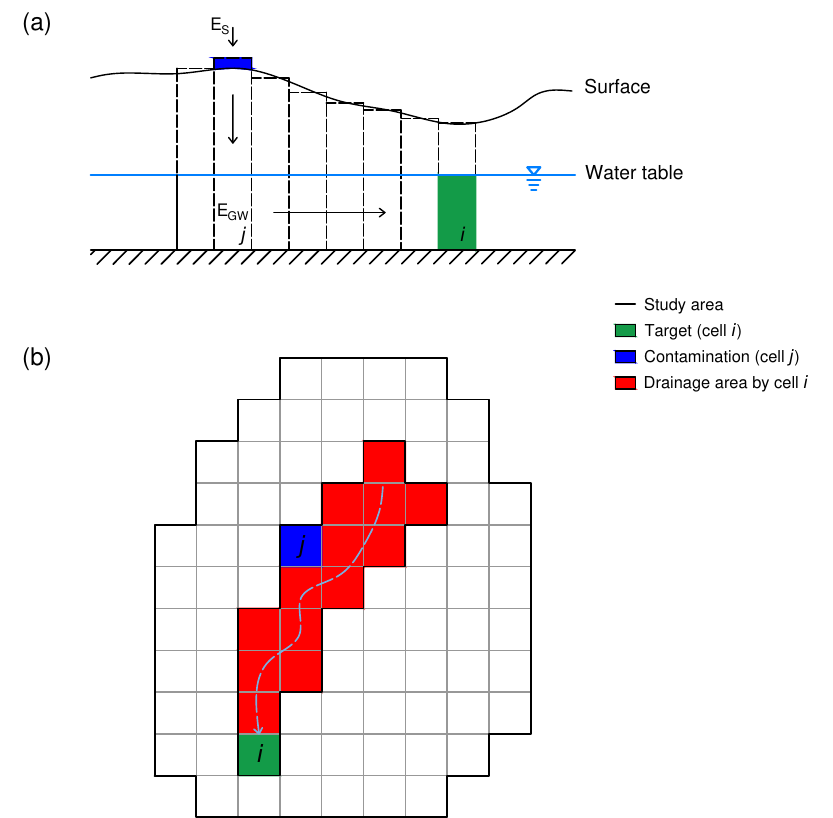
Figure 1. Conceptual scheme of the model: the area of interest is divided in N cells of equal size; ( a ) vertical section with the contaminant schematic flow paths representation; E S and E GW are, respectively, the event of contamination occurring at the surface and in the groundwater. The contaminant trajectory follows first a vertical path along the soil and the vadose zone (unsaturated porous medium) and then moves sub-horizontally along the aquifer (saturated porous medium), to reach a specific control plane or target. ( b ) Planar section with the subcatchment drained by the generic cell i ; we assume that the contamination occurs only in one cell (generic cell j ) within the groundwater subcatchment feeding cell i